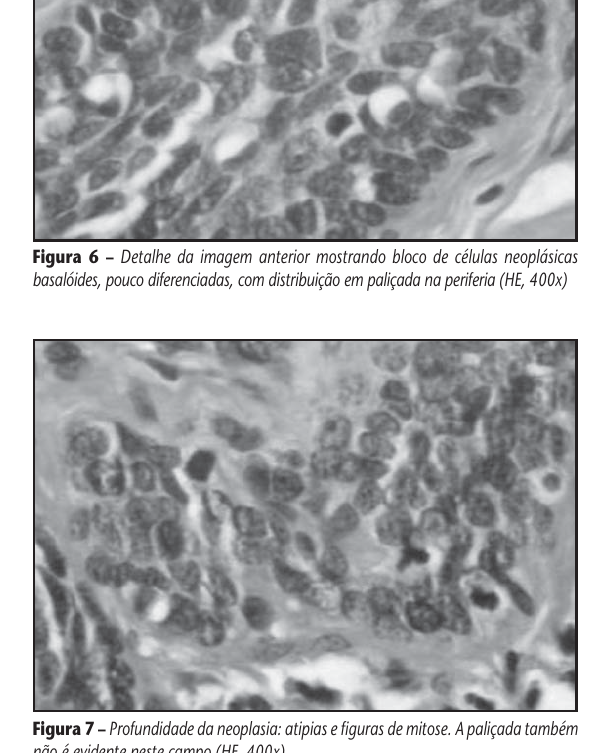
Figura 7 – Profundidade da neoplasia: atipias e fi guras de mitose. A paliçada também não é evidente neste campo (HE, 400x)